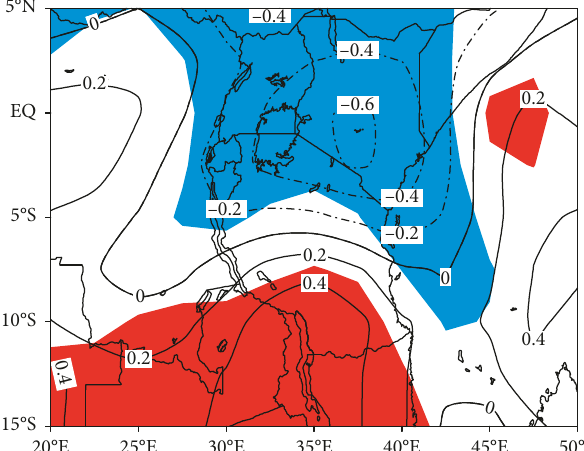
Figure 14: Composite spatial pattern for the 200hPa vertical velocity anomaly (contour intervals 0.2 anomalous HREs based on 1980–2010 climatology. Negative values indicate upward motion, while shading represents significant areas at 95% confidence